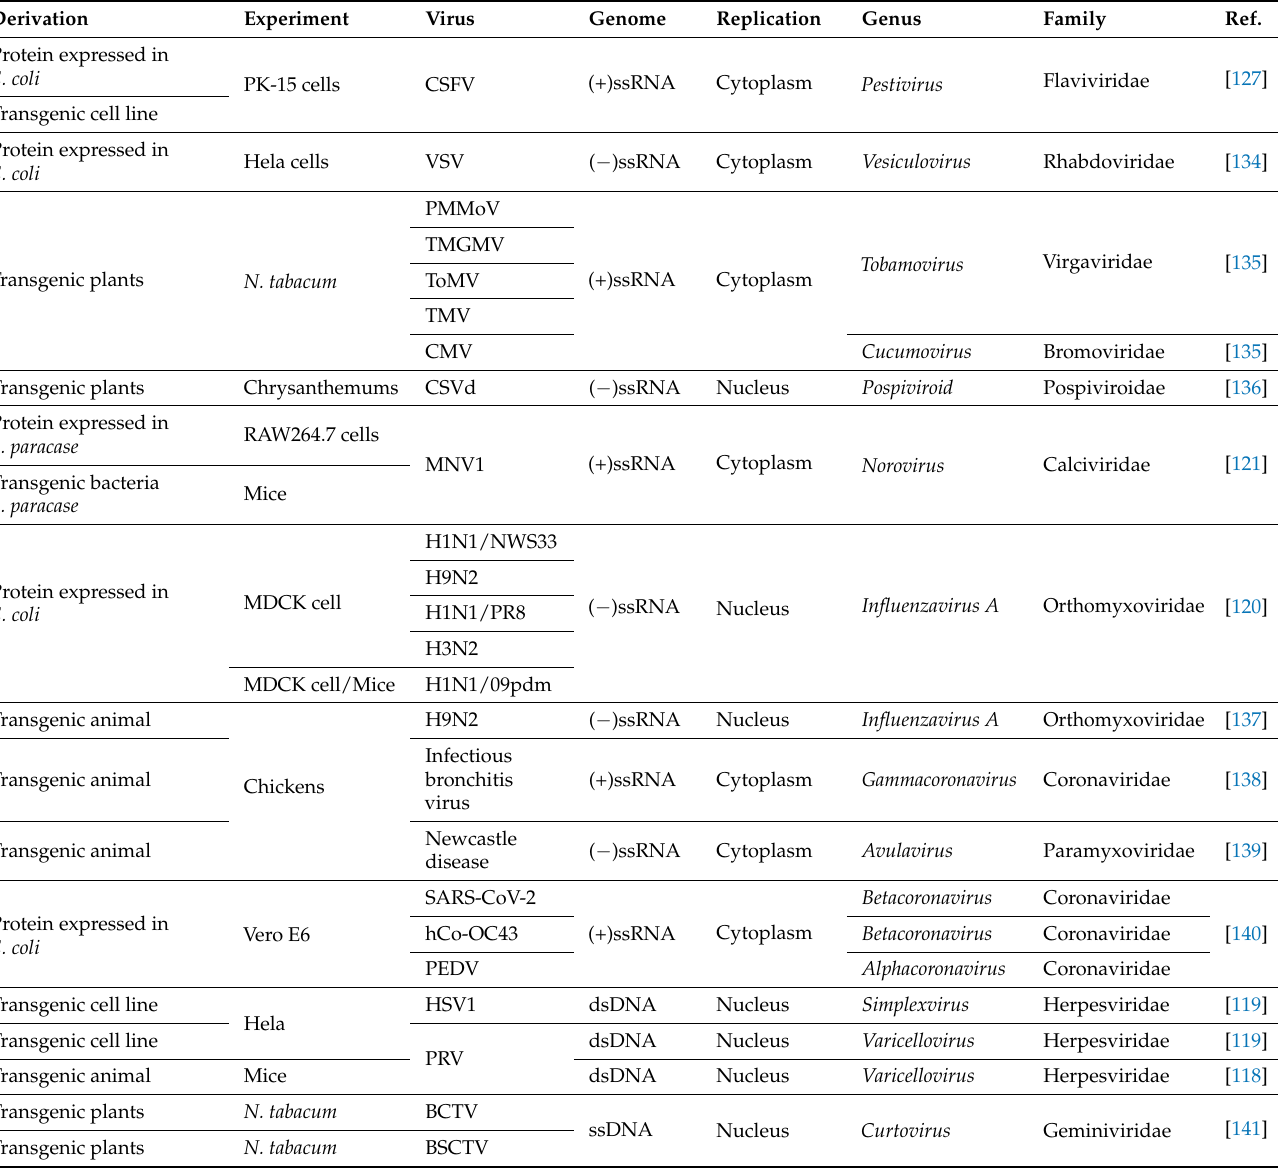
Table 4. 3D8 scFv hydrolyzes viral genomes exhibiting antiviral activity against broad-spectrum